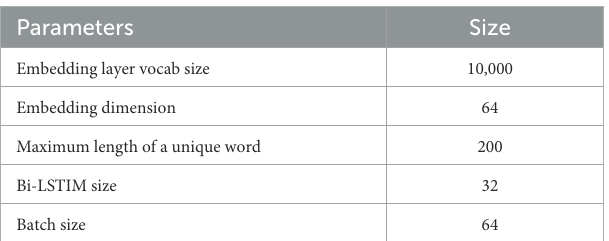
TABLE 2 Parameters of Bi-LSTM model